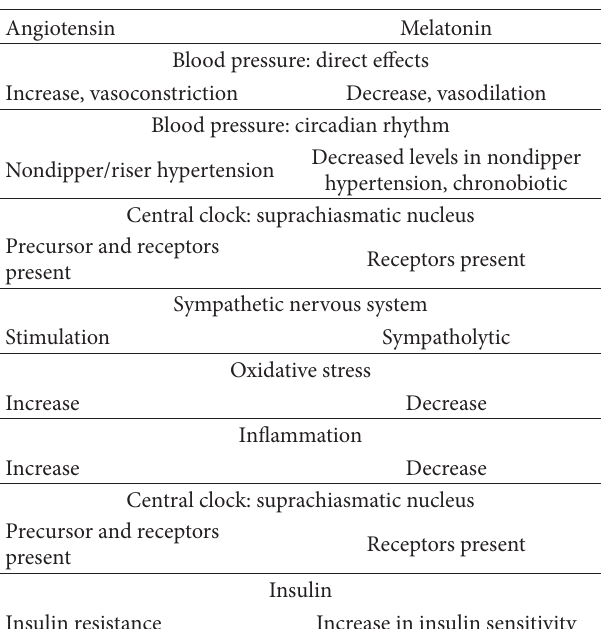
T 1: Opposing roles of angiotensin II and melatonin in cardiovascular and metabolic